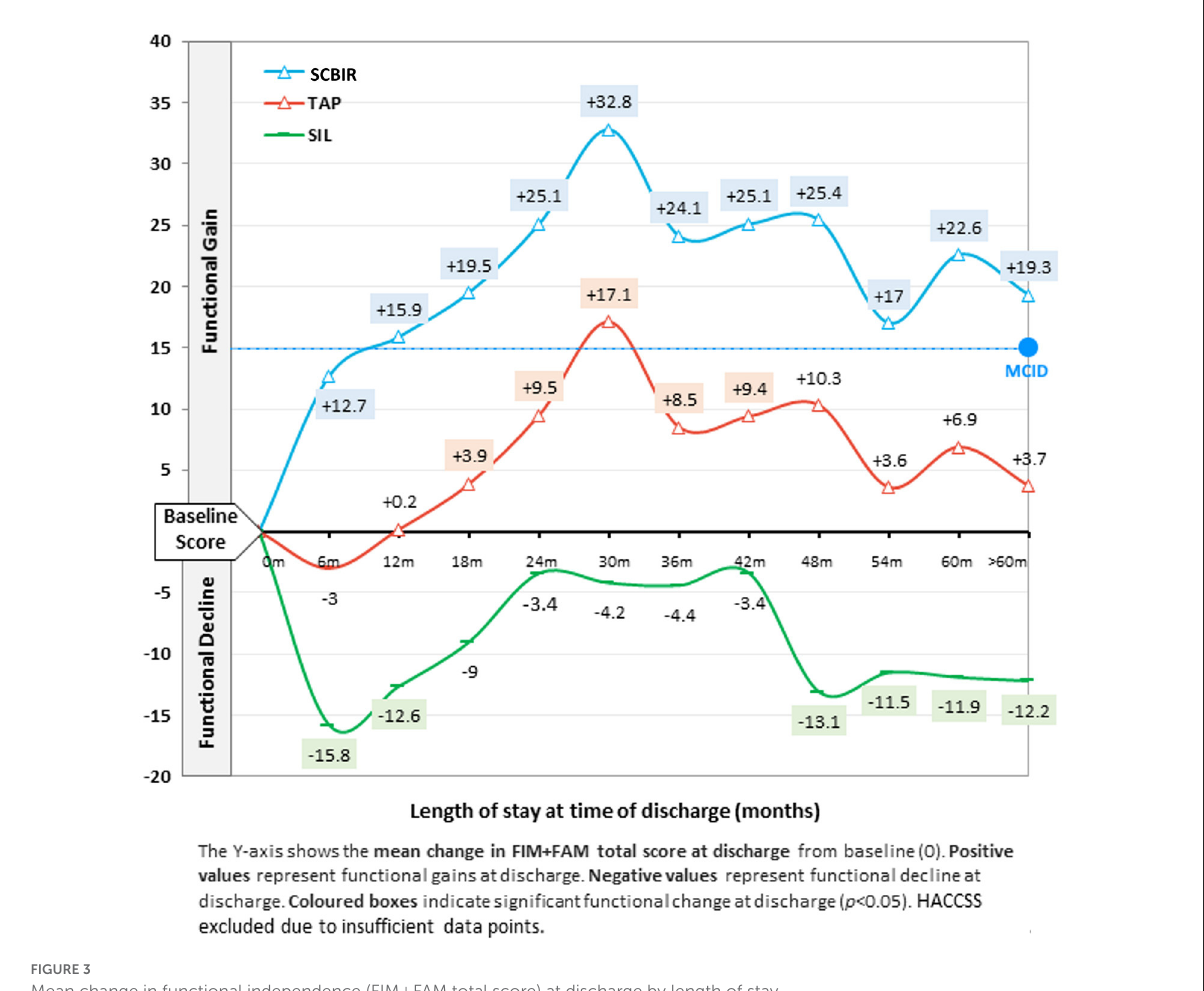
FIGURE3 Mean change in functional independence (FIM + FAM total score) at discharge by length of stay.